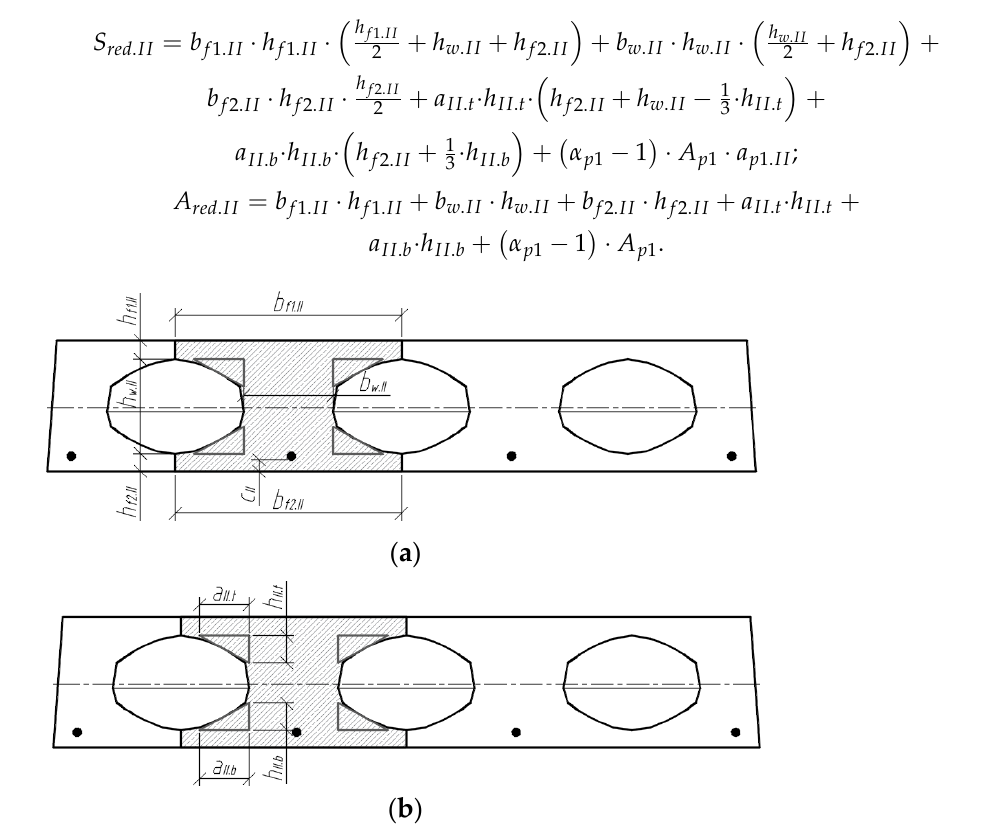
Figure 11. Analysed cross-section II-II; ( a ) edge parameters; ( b ) parameters of the triangular sections of the cross-section.